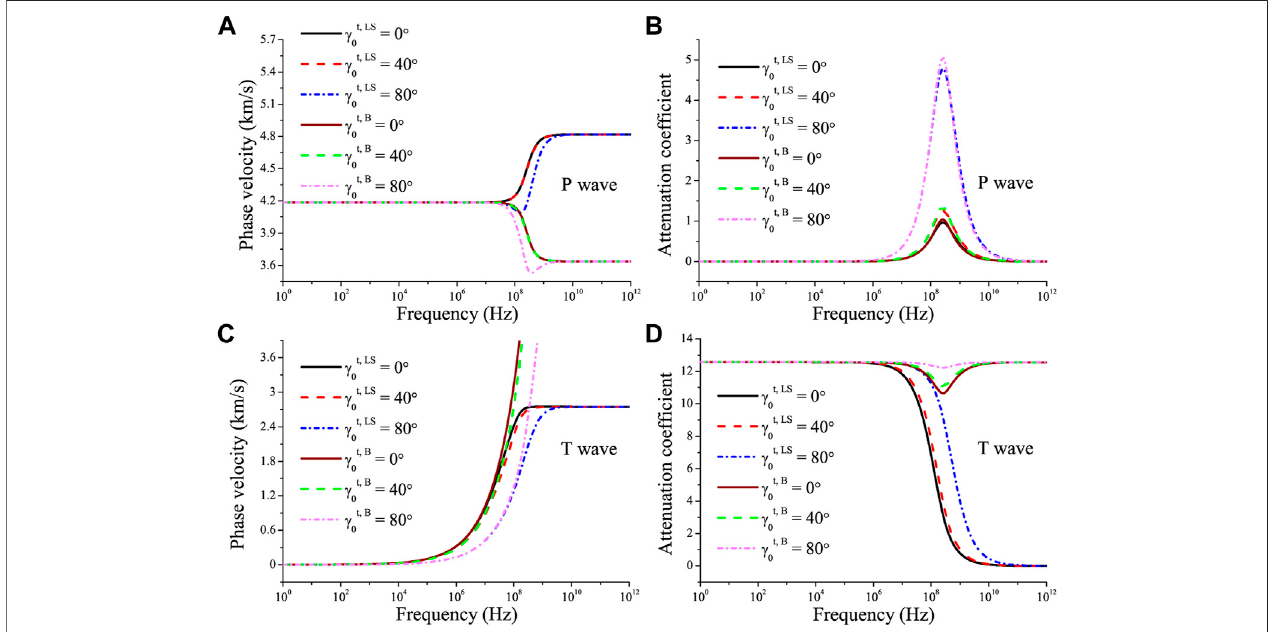
FIGURE 3 | Phase velocity and attenuation coef fi cients of the P wave (A,B) and T wave (C,D) as a function of frequency in the transmission medium with different γ 0 . The superscripts LS and B represent the Lord-Shulman and classical-Biot theories, respectively.